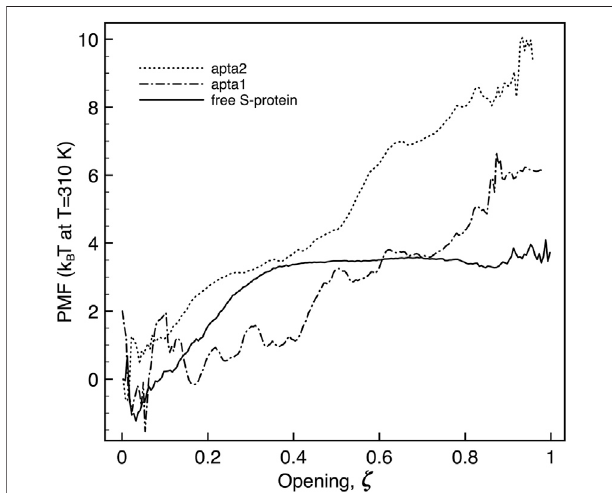
FIGURE 7 | Plot of the potential of mean force extracted along the opening pathway ζ , for the free S-protein (full line), and the S-protein with one DNA aptamer docked (dashed lines). The free energy is in all cases estimated by the difference between the maximum and minimum value of the PMF along the reaction